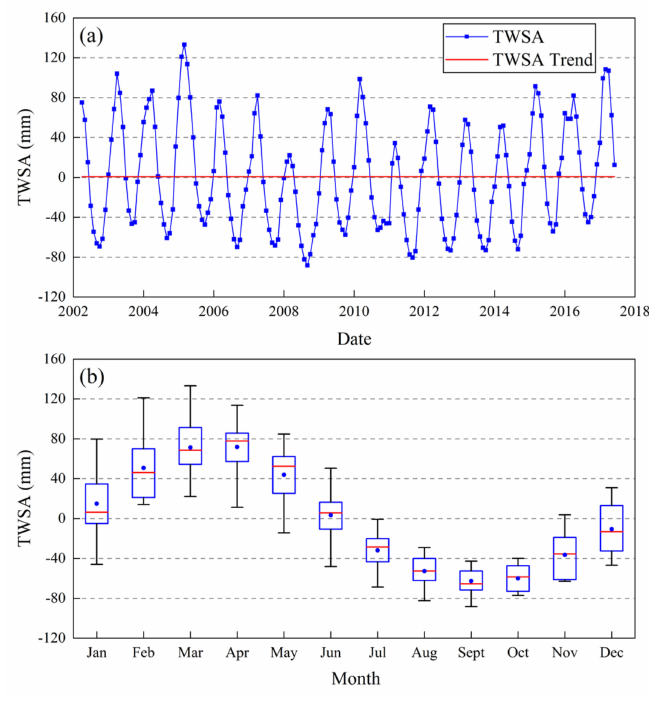
Figure 7. The variations in TWSA ( a ) and year-to-year variations in monthly TWSA ( b ) of the Aral Sea Basin from GLDAS during the period of April 2002 to June 2017. In ( b ), the red horizontal lines represent the month’s median TWSA, the blue dots represent the month’s average TWSA, the boxes represent the inner-quartile range, and the whiskers represent the full range of the